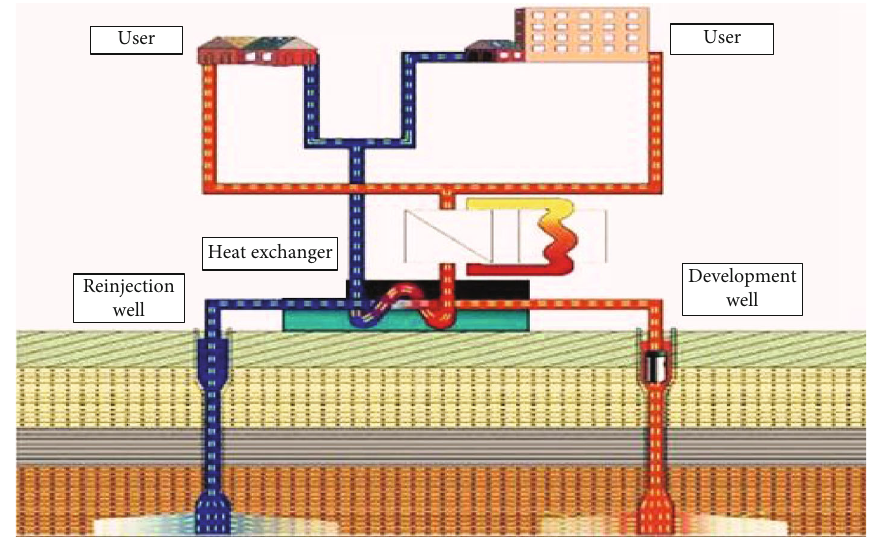
Figure 2: Diagram of reinjection e ff ect of heat storage tail water in medium deep sandstone.